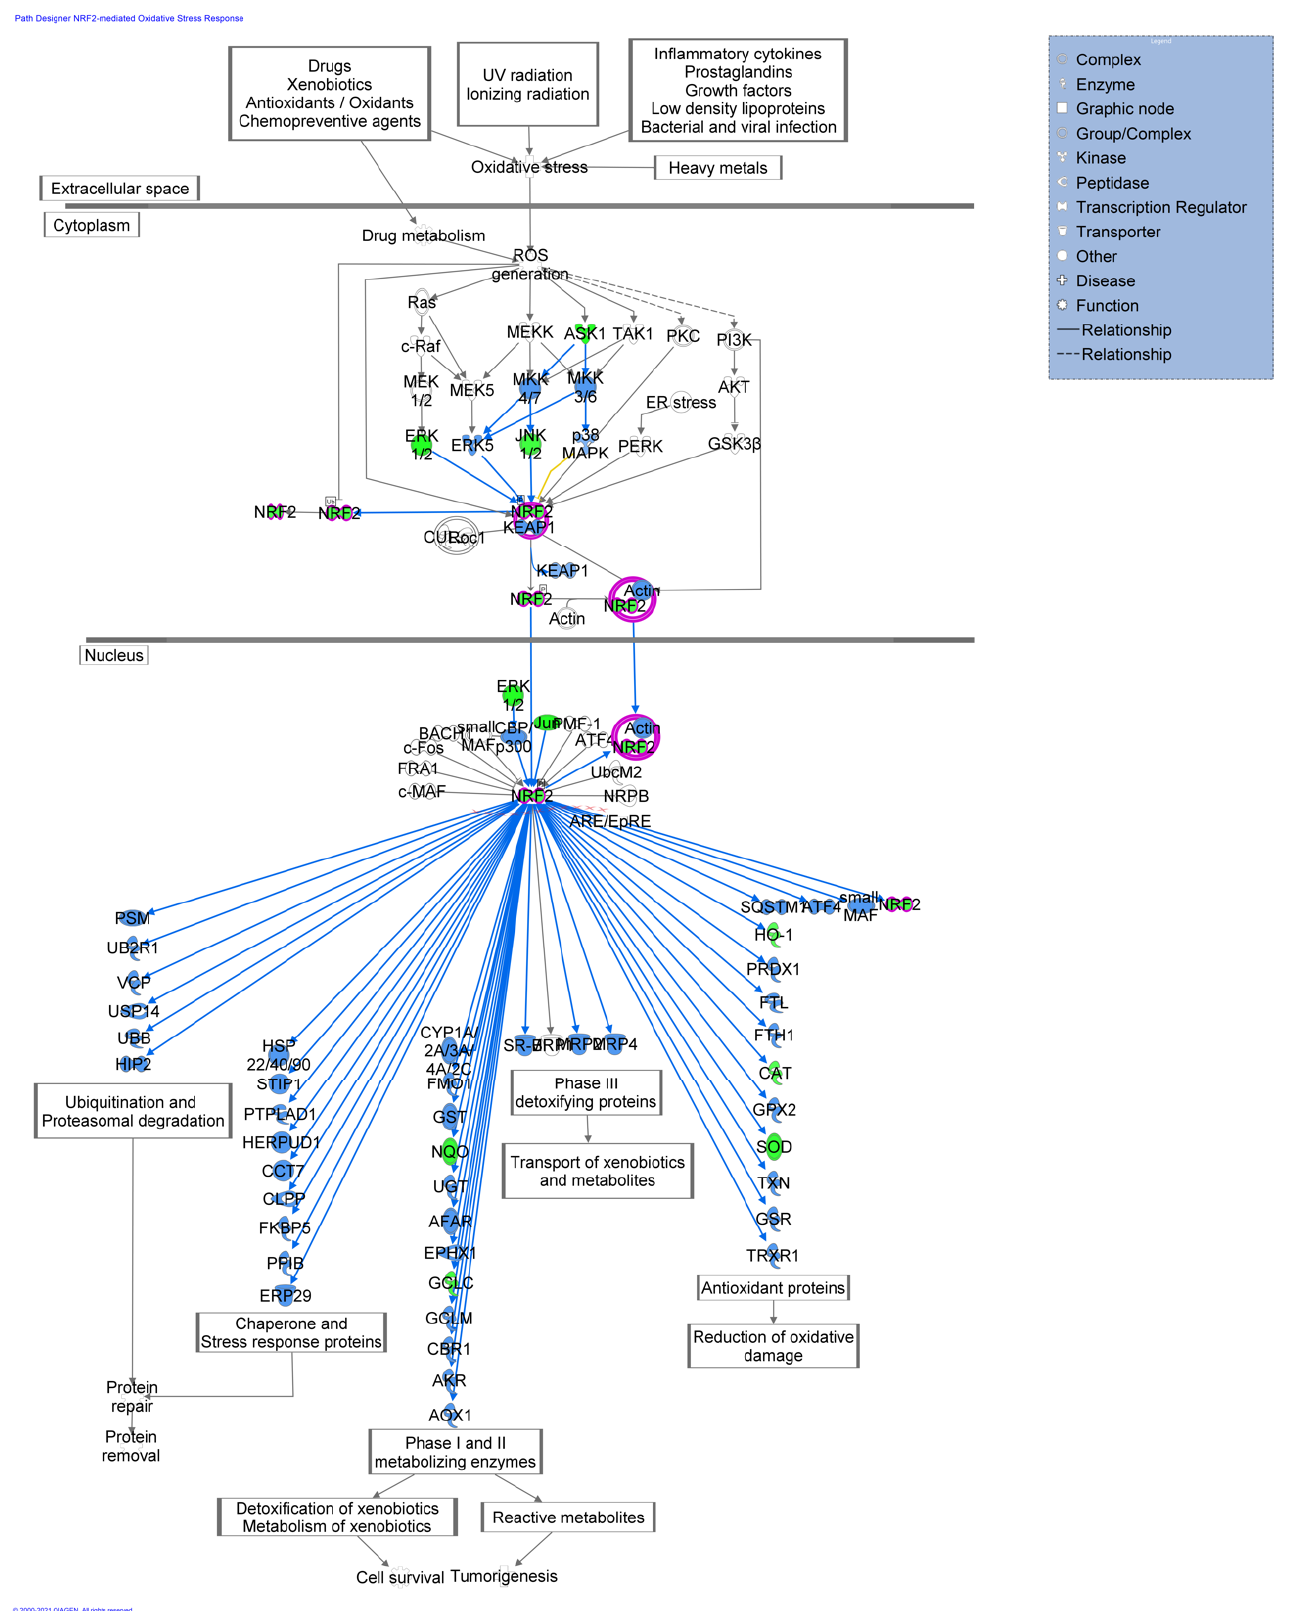
Figure 5. NRF2 oxidative stress signalling pathway was identified as a top canonical pathway by IPA following the analysis of gene changes in CCs cells from the smokers group when compared with the non-smokers group. Down-expressed genes are depicted in green while genes in white are the ones inferred by IPA.